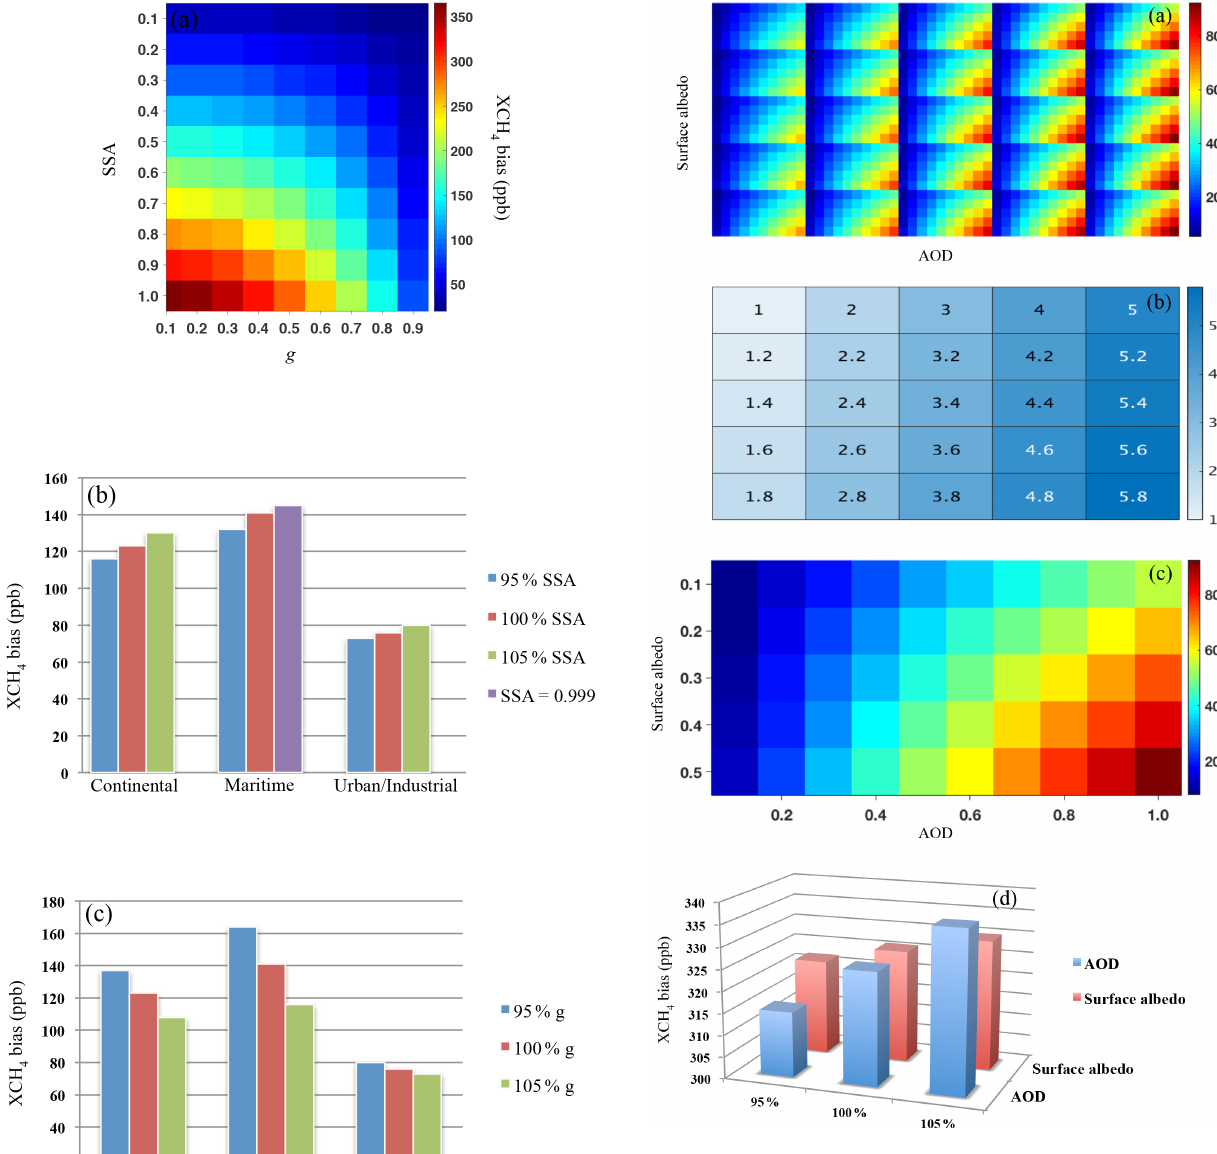
Figure 8. (a) CH 4 retrieval biases for different values of XCH 4 , AOD, and surface albedo. g = 0 . 75; SSA = 0 . 95. (b) XCH 4 for each box in (a) . (c) Zoomed-in plot of bottom right box (XCH 4 = 5 . 8 × 1 . 822ppm). The x and y axes show the variation in AOD and surface albedo, respectively. These changes are identical for every box in (a) . (d) CH 4 retrieval biases for a ± 5% change in AOD and surface albedo from a base value of 0.3 ( g = 0 . 75, SSA = 0 . 95, XCH 4 = 5 . 8 × 1 .